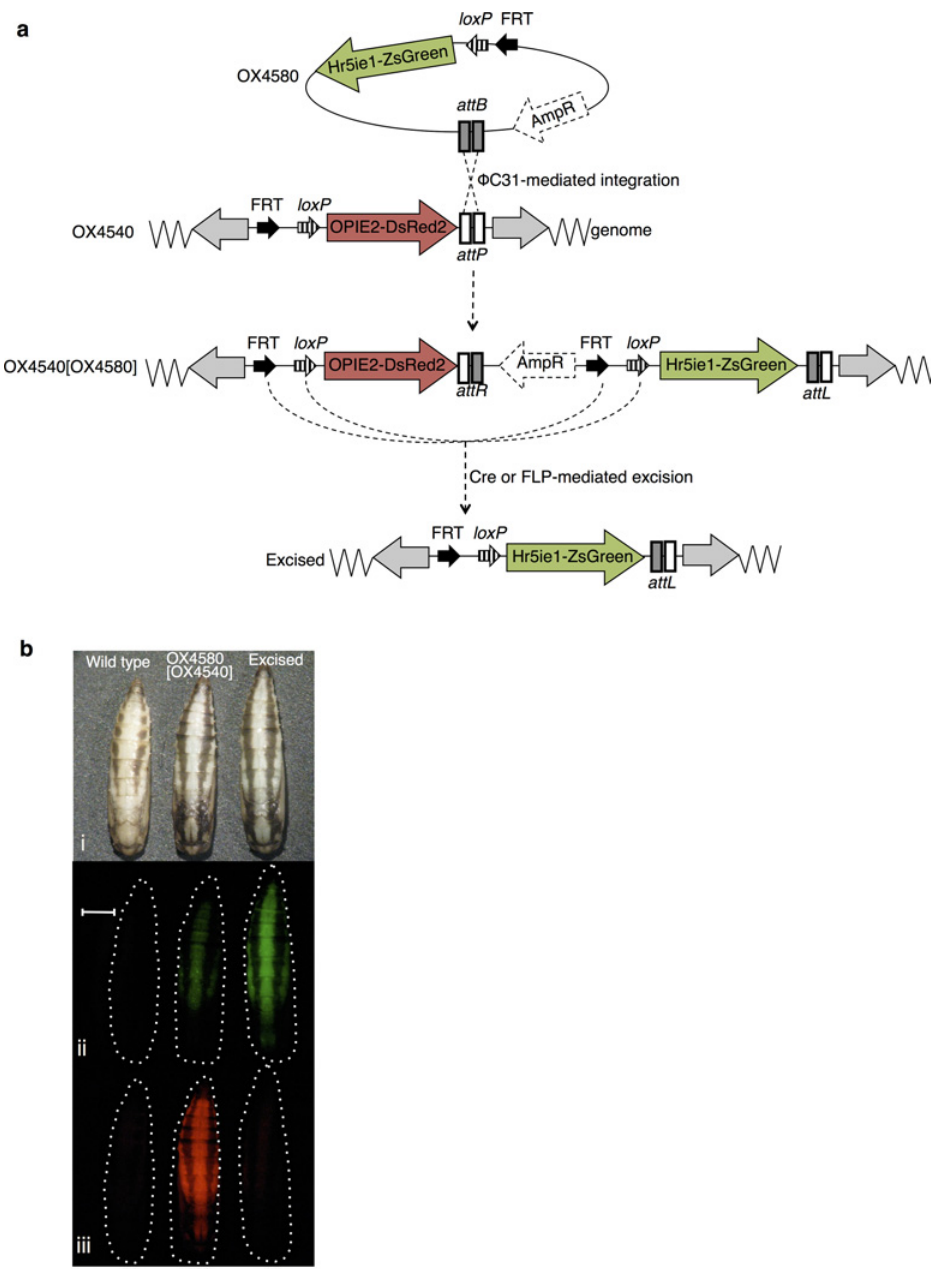
Fig 3. iRMCE in P . xylostella . (a) Schematic diagram of iRMCE in P . xylostella and (b) corresponding fluorescent phenotypes in P . xylostella pupae. Black arrows indicate engineered FRT and loxP sites present in donor and acceptor constructs; AmpR represents the plasmid backbone sequences, which includes the ampicillin-resistance gene; grey arrows indicate piggyBac ends. Pupae are shown under (i) white light, (ii) green excitation light and filters, and (iii) red excitation light and filters. Images (i – iii) were taken under the same magnification. Scale bar repersents 1 mm.